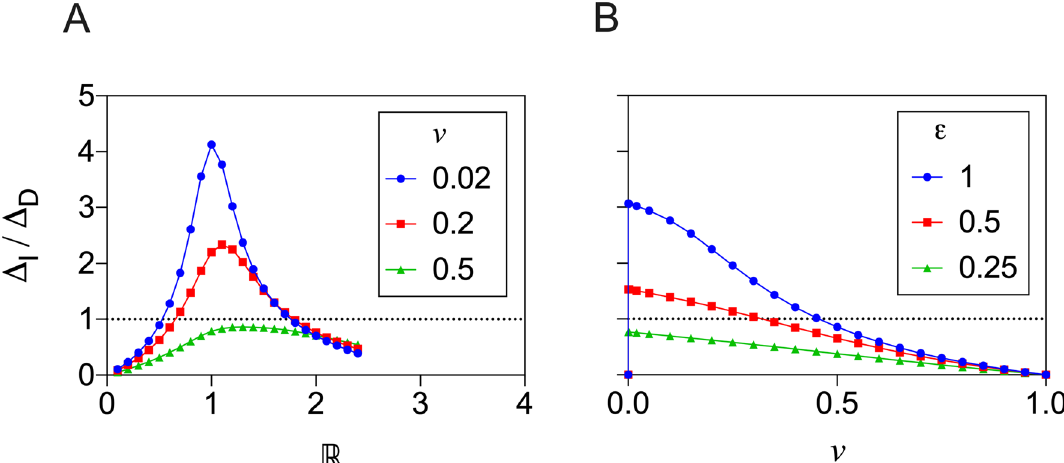
Figure 4. Ratio of indirect to direct benefits. The ratio � I /� D is plotted as a function of the basic reproduction number, R , (Panel A ), and as a function of the vaccination rate, v (Panel B ). In Panel ( A ), the ratio is plotted using data from Fig. 2 when the vaccine effectiveness, ε , is set to the value ε = 1.0 , while three different values of the vaccination rate, v , are used: 0.02, 0.2 and 0.5. In Panel ( B ), the ratio is plotted using data from Fig. 3 when the basic reproduction number, R , is set to R = 1.2 , while three different values if the vaccine effectiveness, ε , are used: 1.0, 0.5 and